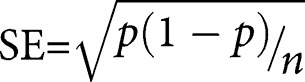
Proportion of D. carinata dispersersing after 96 h across distinct feeding regimes.The effect of 96 h of food deprivation on the proportion of D. carinata that had dispersed into patch 2, both with and without food available in patch 2 (n = 5 container pairs per treatment combination). ***indicates a significant difference between treatment combinations (at P < 0.001), NS indicates a non-significant difference. Each point and line is given by the mean number of D. carinata individuals in patch 2 as a proportion of the total population size between the two patches ± SE. SE was calculated as \documentclass[12pt]{minimal}
\usepackage{amsmath}
\usepackage{wasysym}
\usepackage{amsfonts}
\usepackage{amssymb}
\usepackage{amsbsy}
\usepackage{upgreek}
\usepackage{mathrsfs}
\setlength{\oddsidemargin}{-69pt}
\begin{document}
}{}${\rm{SE}} = \sqrt {{p\left( {1 - p} \right)}}/ n$\end{document}SE=p(1−p)n, where p is the proportion of dispersers and n is the number of individuals in the container pair. Food availability in patch 1 alone was found to have a significant effect on the proportion of the population that dispersed (Table 2).